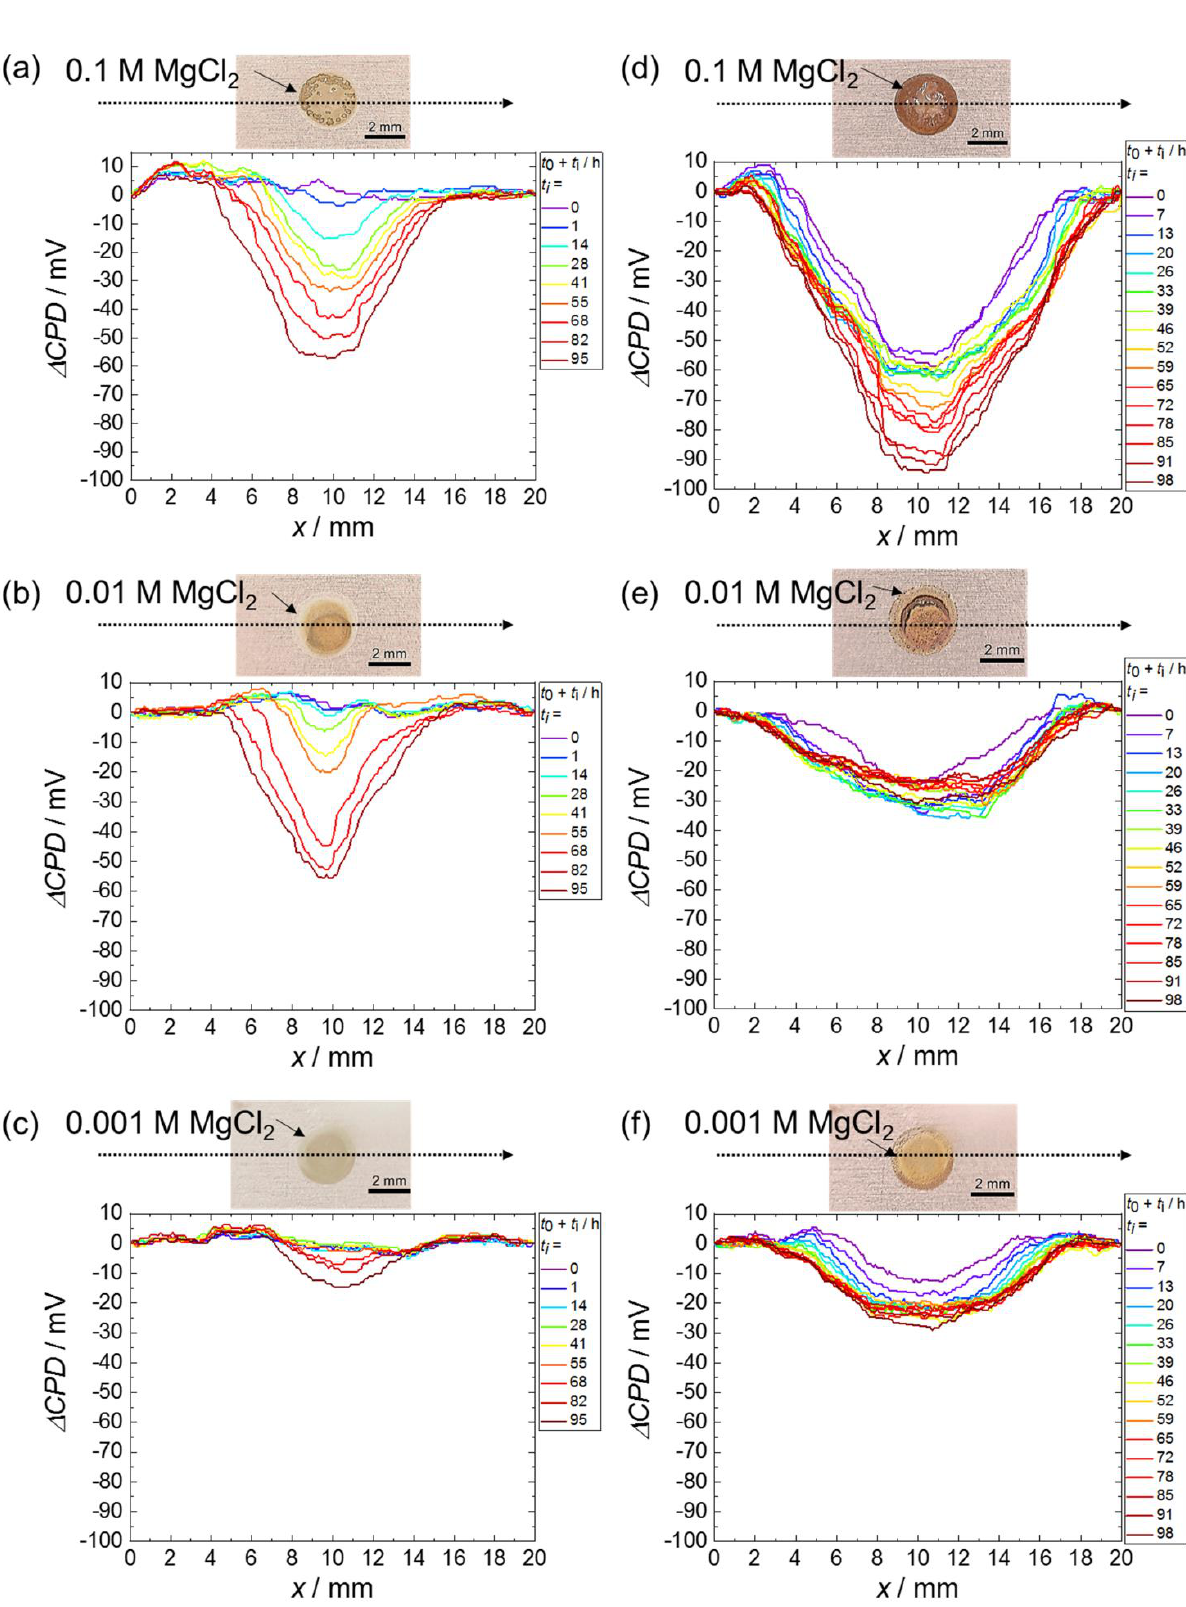
Figure 3. CPD line profiles in x-direction at y-position of CPD min after background subtraction ( ∆ CPD values) measured up to 90 h after application of ( a ) 0.1 M, ( b ) 0.01 M, and ( c ) 0.001 M MgCl 2 . aq in comparison with corresponding results after rewetting of the droplets ( d – f